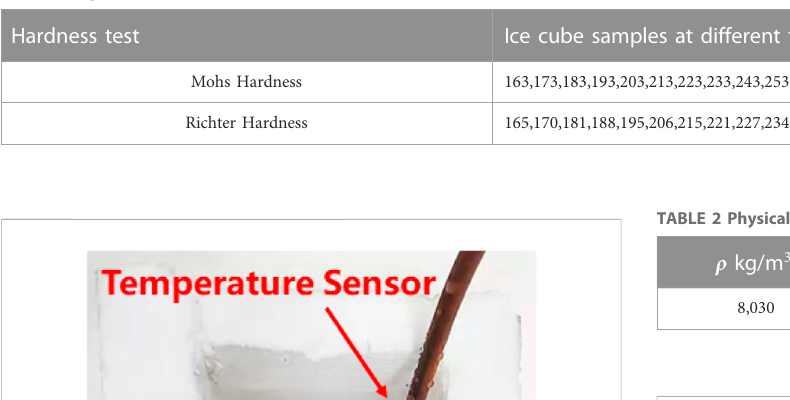
TABLE 1 Experimental scheme.